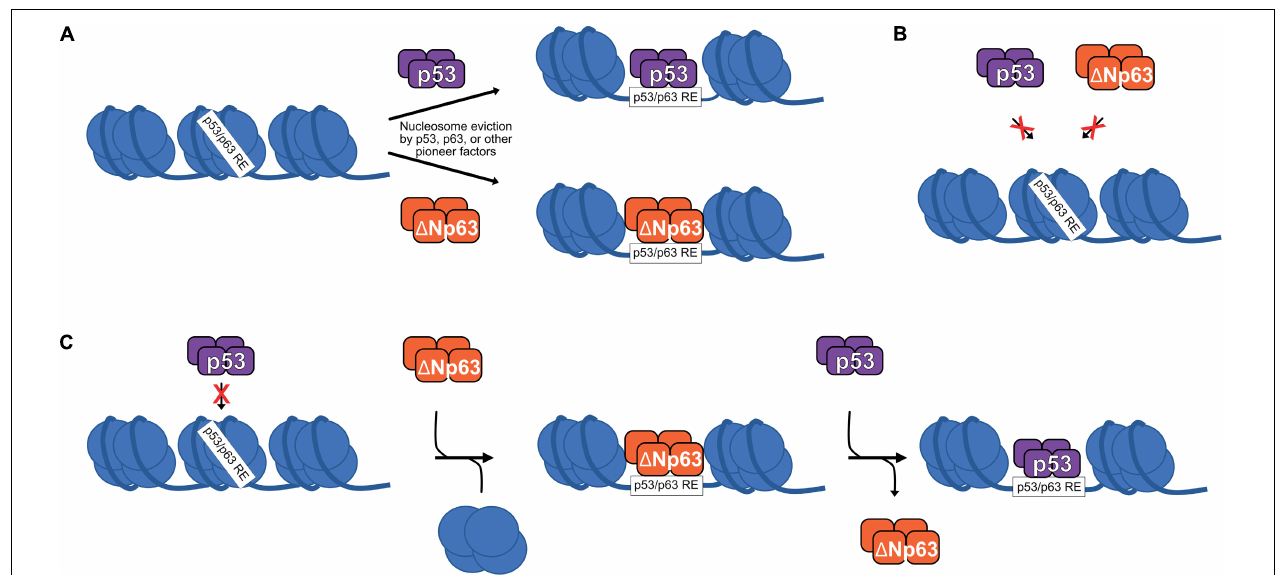
FIGURE 2 | (A) p53 and (cid:49) Np63 can act as pioneer factors to evict/remodel nucleosomes and facilitate DNA accessibility, although other pioneer factors are likely responsible for nucleosome eviction at the majority of p53/ (cid:49) Np63 binding sites. (B) Certain nucleosome contexts, such as when the p53/p63 RE motif is near the nucleosome dyad, are recalcitrant to p53 and/or (cid:49) Np63 pioneer factor activity and remain unbound (Yu and Buck, 2019; Yu et al., 2021). (C) In epithelial cell types, p53 DNA binding can be facilitated by (cid:49) Np63 (cid:48) s pioneer factor activity, although specific biochemical mechanisms are still being fully